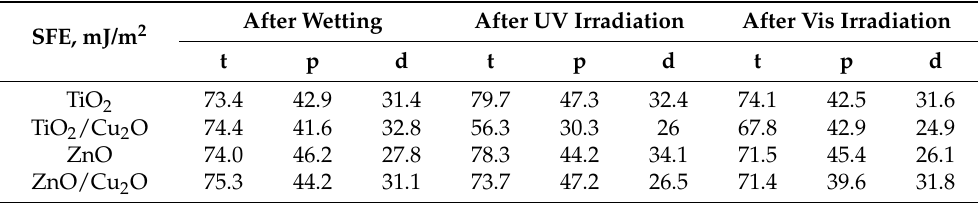
Table 4. Total (t), polar (p), and dispersive (d) surface free energies (SFE) for all coatings studied after different treatments.